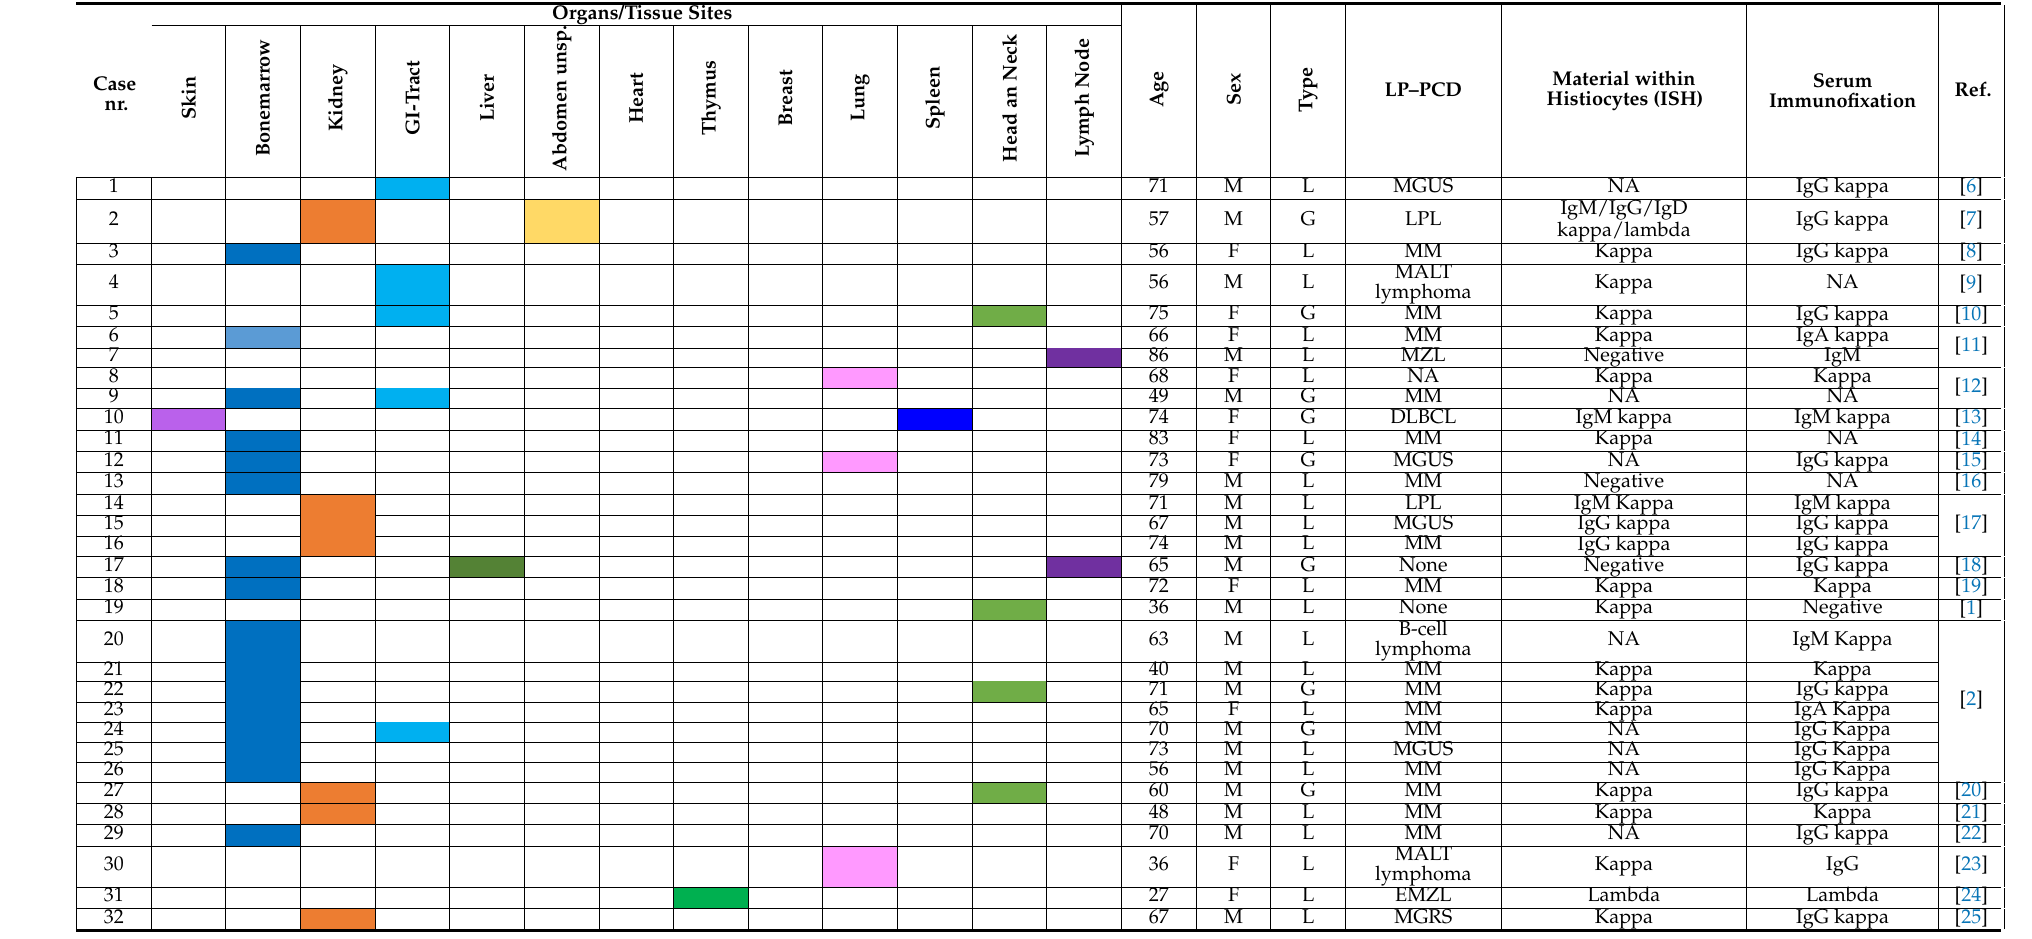
Table 2. Overview of literature